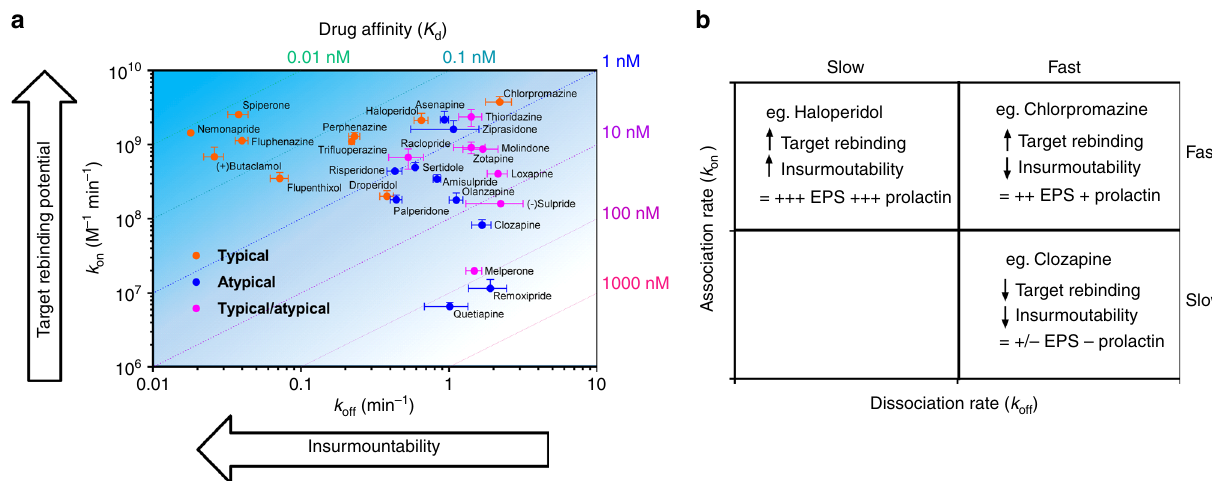
Fig. 5 Summarizing the role of kinetics and rebinding in dictating the “ on-target ” AP toxicity. a APD D 2 R kinetic map showing SGA/atypical ( blue ), FGA/typical ( red ), and APDs described as both typical and atypical ( green ) plotted using their respective dissociation rate ( k off ) and association ( k on ) constants, with the combinations of k off and k on that result in identical af fi nity ( K d ) values represented by diagonal dotted lines . The arrows on graph indicate the directions of increasing rebinding potential and insurmountability (due to hemi-equilibrium) dictated by k on and k off , respectively, with the heat map representing the overall rate of binding reversal ( k r ) from the D 2 R. b Three types of APD are identi fi ed from this kinetic study and represented in the box plot along with their relative potential for “ on-target ” toxic effects indicated by the following; ( − ) no evidence, (+) some evidence, moderate (++) and (+++) strong evidence. Kinetic values are presented as mean ± s.e.m. from four